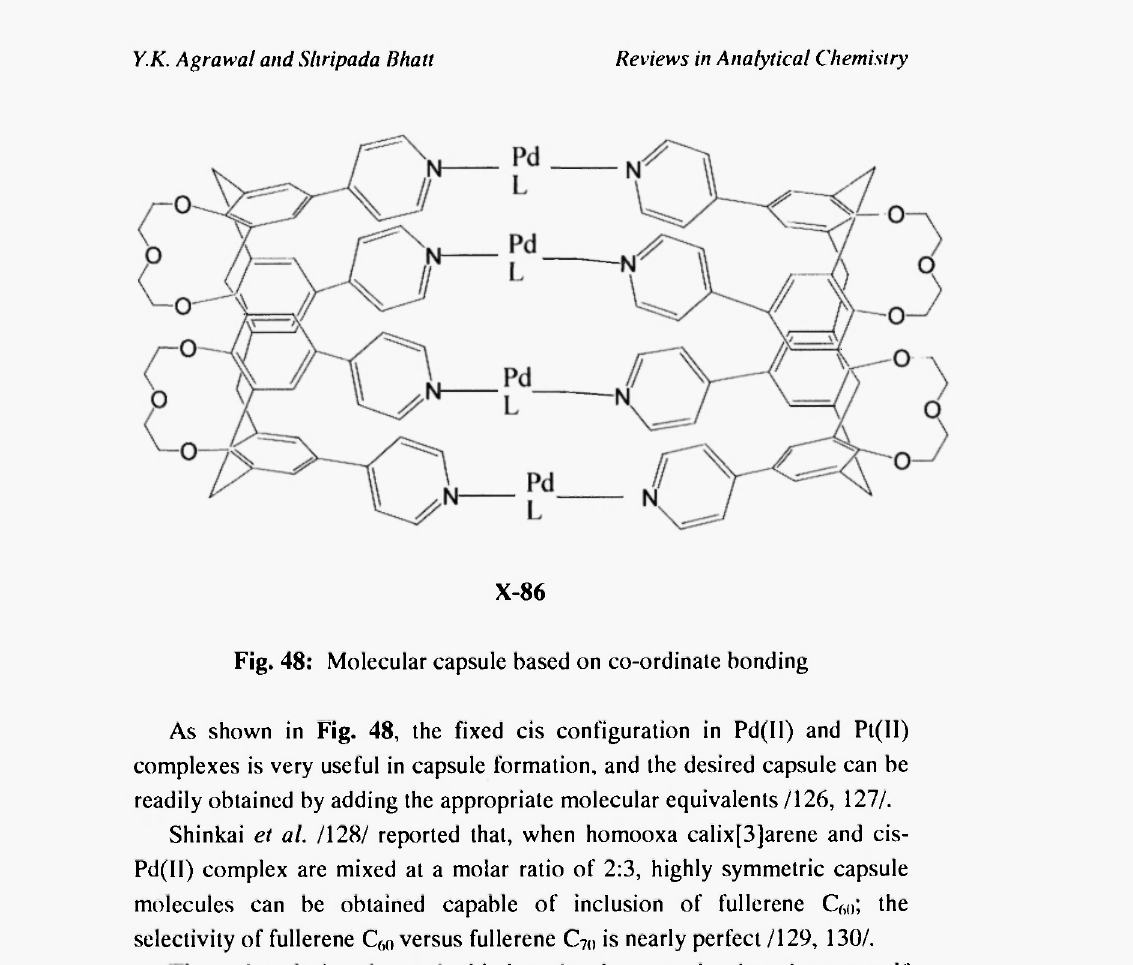
Fig. 48: Molecular capsule based on co-ordinate